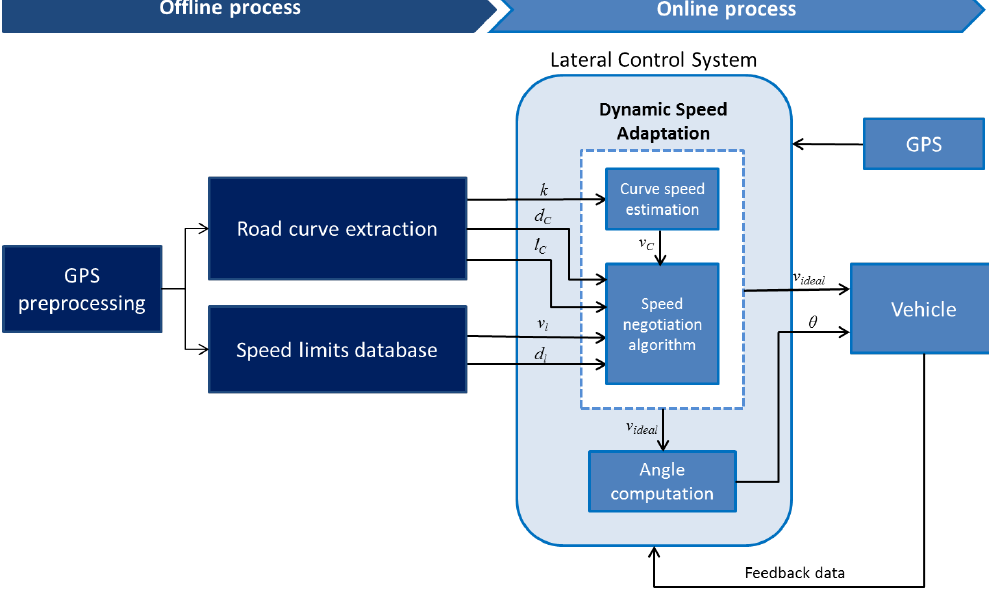
Figure 2. Overall data-flow of the dynamic speed adaptation